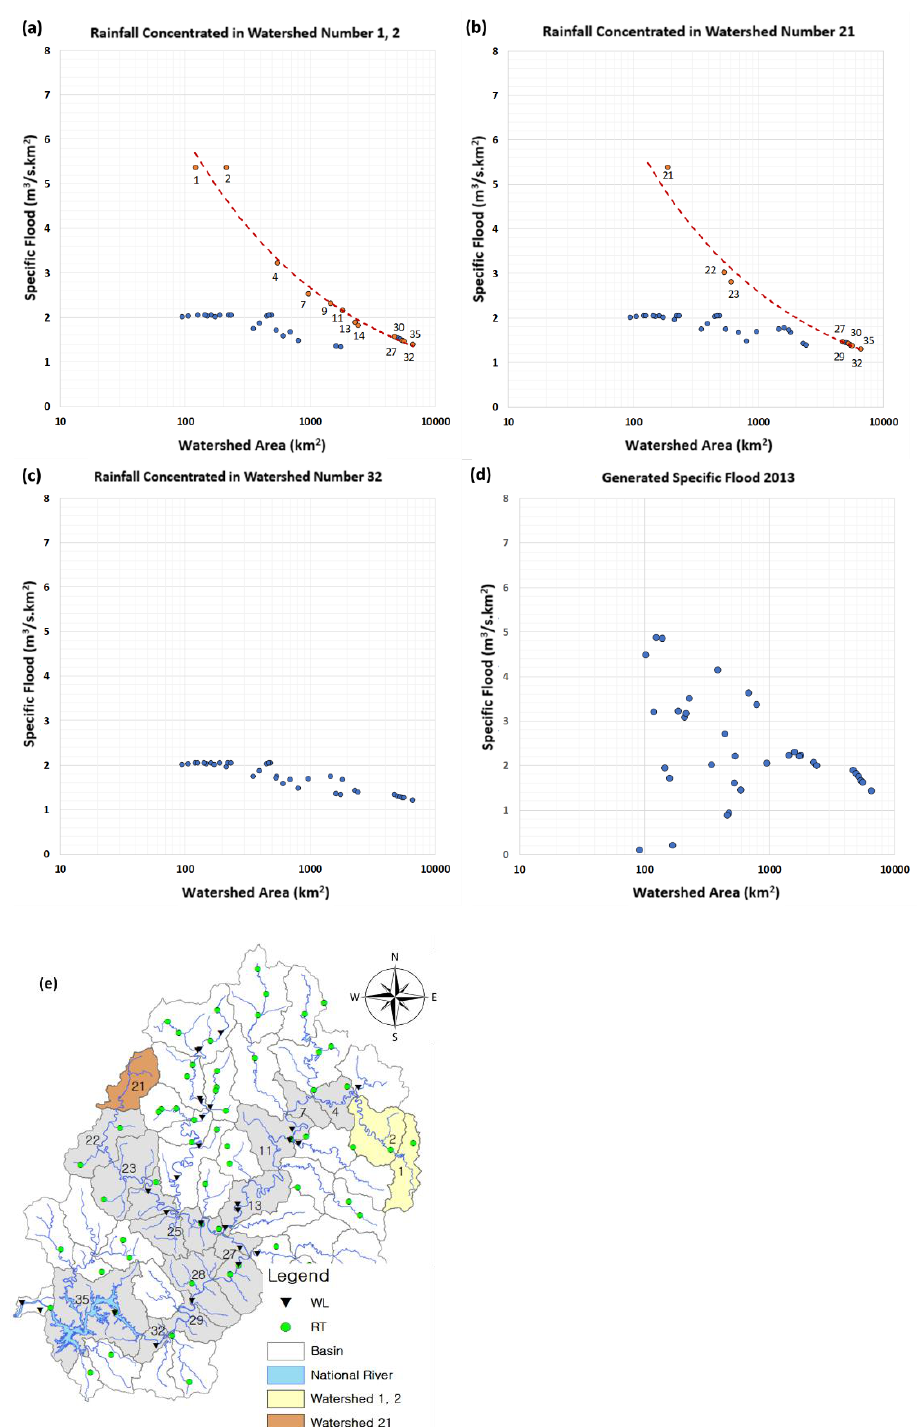
Figure 7. Power–law patterns based on the rainfall concentrated locations ( a ) upstream watershed 21, ( b ) upstream watersheds 1 and 2, ( c ) downstream watershed 32, ( d ) rainfall patterns for an event in 2013), ( e ) concentrated rainfall at watershed 21 (20 mm/hr) or watersheds 1 and 2 (20 mm/hr), with consistent rainfall at other watersheds (10 mm/hr).